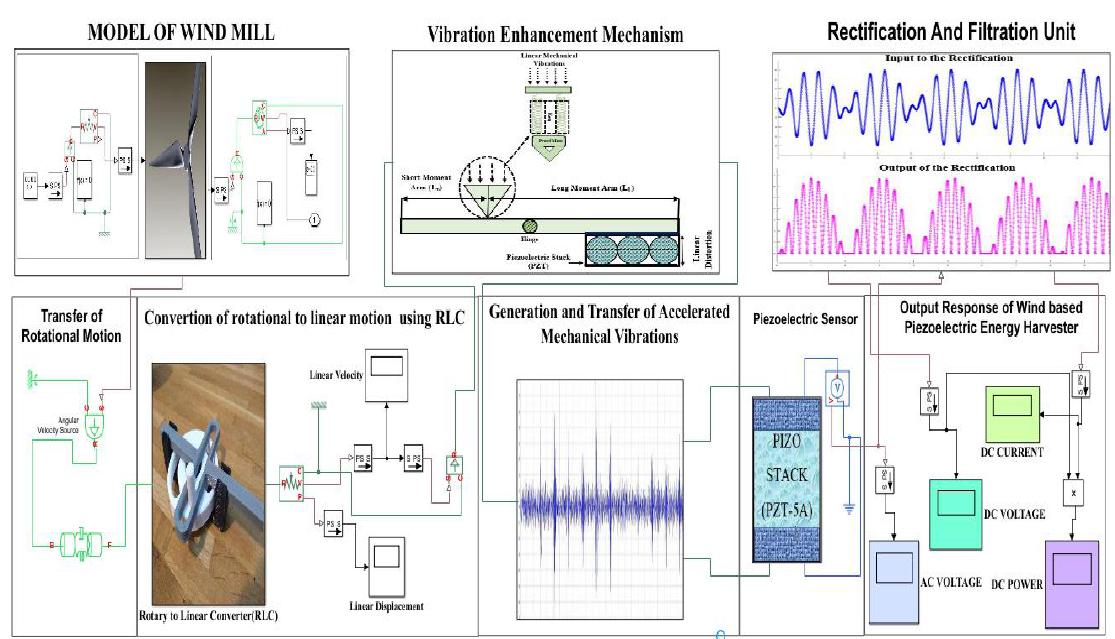
Figure 5. Complete model of piezoelectric wind energy harvester on SIMSCAPE. After it, the generated alternative voltage is interfaced with the electrical circuit, which contains a full-bridge rectifier to acquire the pulsating DC output of the energy harvester as shown in Figure 5. Additionally, the filter capacitor is connected in parallel with the resistive load to remove the undesirable frequencies (AC-Part) of the signal. Numerical analysis of the proposed model is used to observe the effects of input variables such as wind speed, rotor angular velocity, resistive load, number of rotor-blades, PZT thickness, and stiffness on the electrical output of the energy harvester. And it is contemplated that wind speed has square and cubic relationships to the output voltage and power, respectively. In contrast, a non-linear relationship is observed between the number of blades of the rotor and harvested energy. Since air is the main working fluid in wind energy harvesters, so for a fluid with density ( ρ ) flowing through the rotor of cross-sectional area (A), the mass flow rate is given in Equation (12).